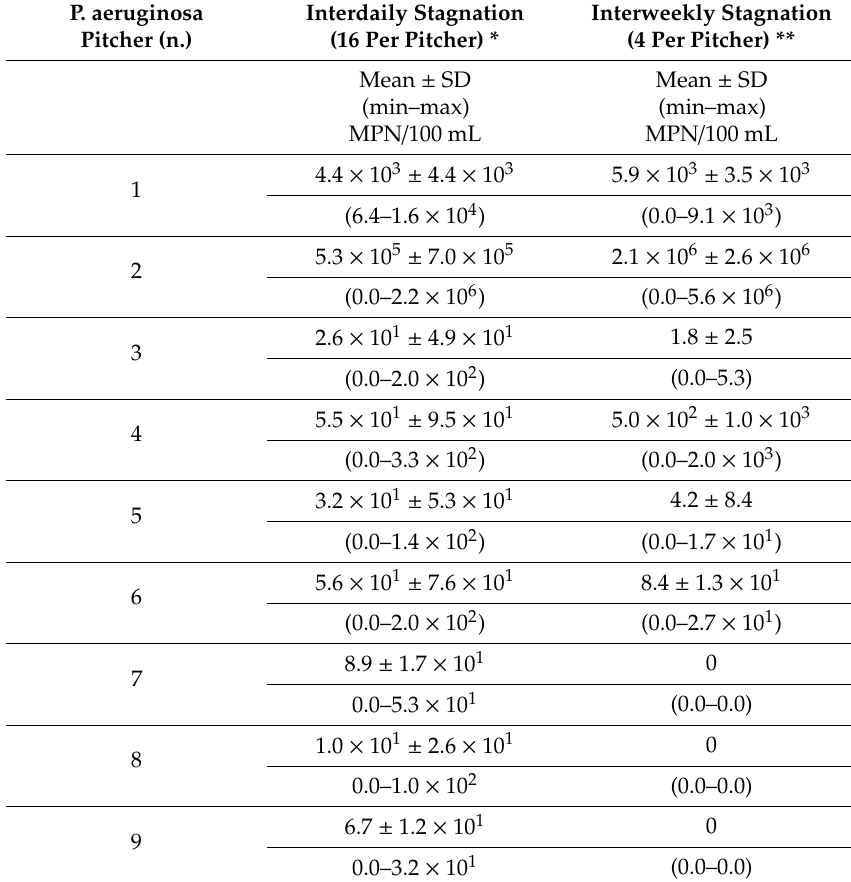
Table 2. P. aeruginosa concentrations from interdaily and interweekly stagnation water (9 pitchers tested for 4